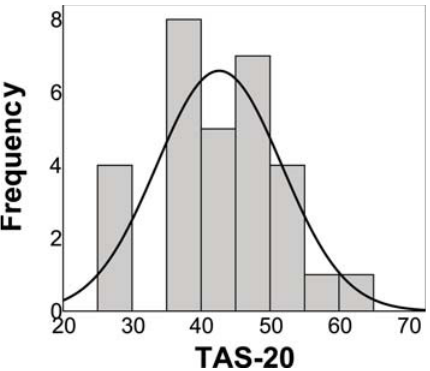
Figure 2. Distribution curve of the overall scores of TAS-20.